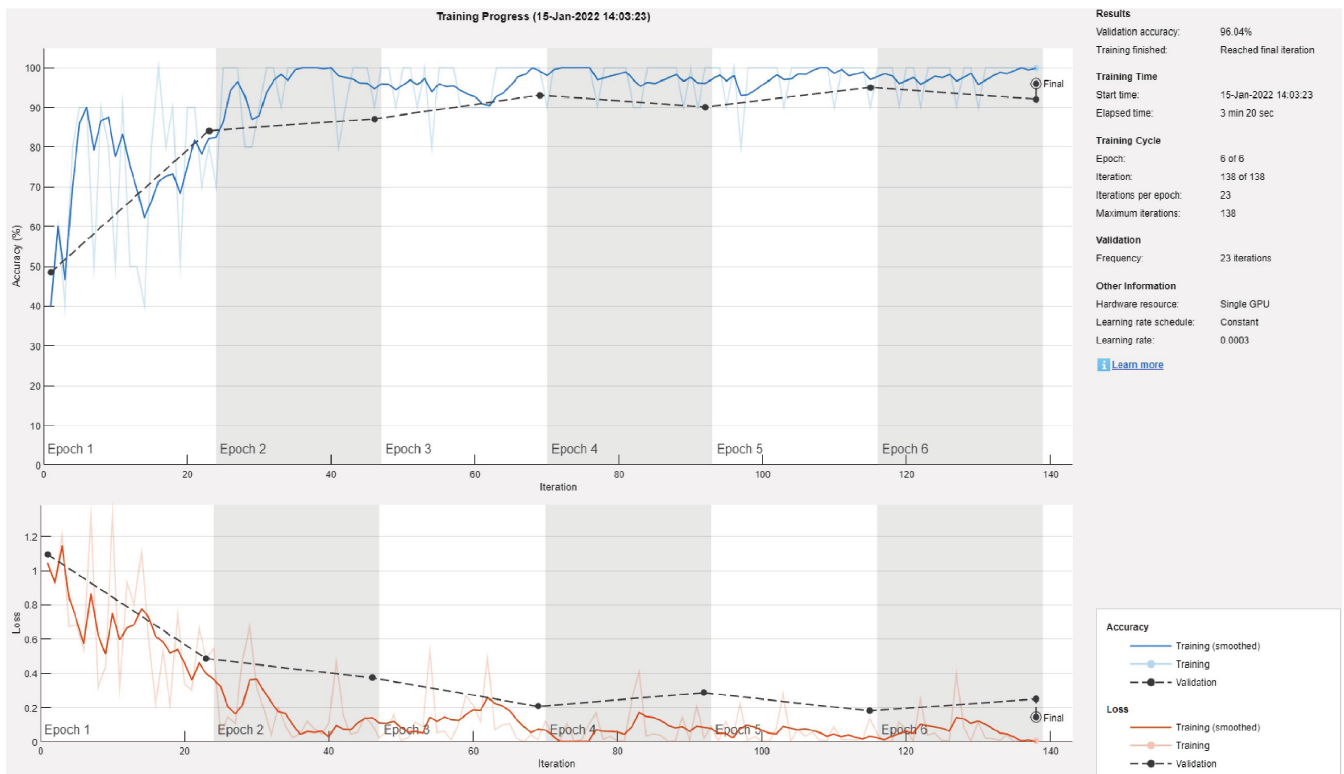
Fig 2. The DenseNet-201 sample training and validation curve for three-class